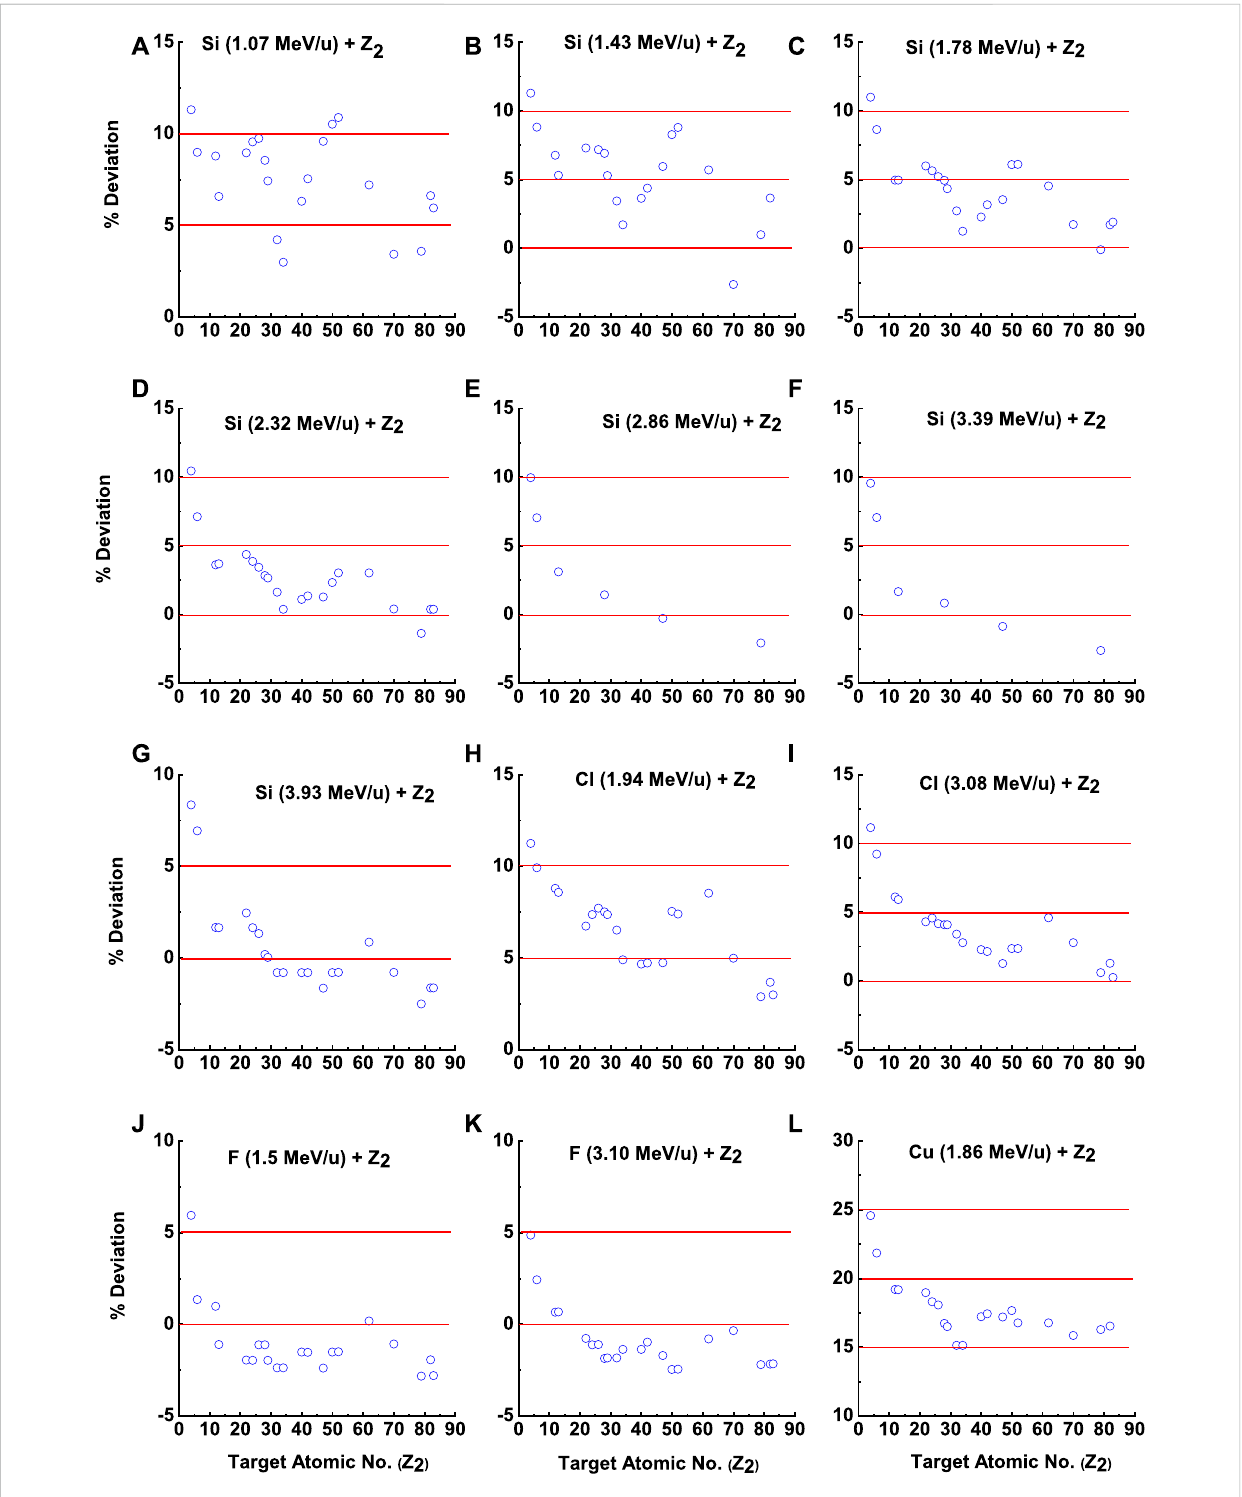
FIGURE 3 Comparison of the percentage of deviation of the Z-B-L model and the experimental mean charge state (cid:1) q as a function of Z 2 (A-L) .